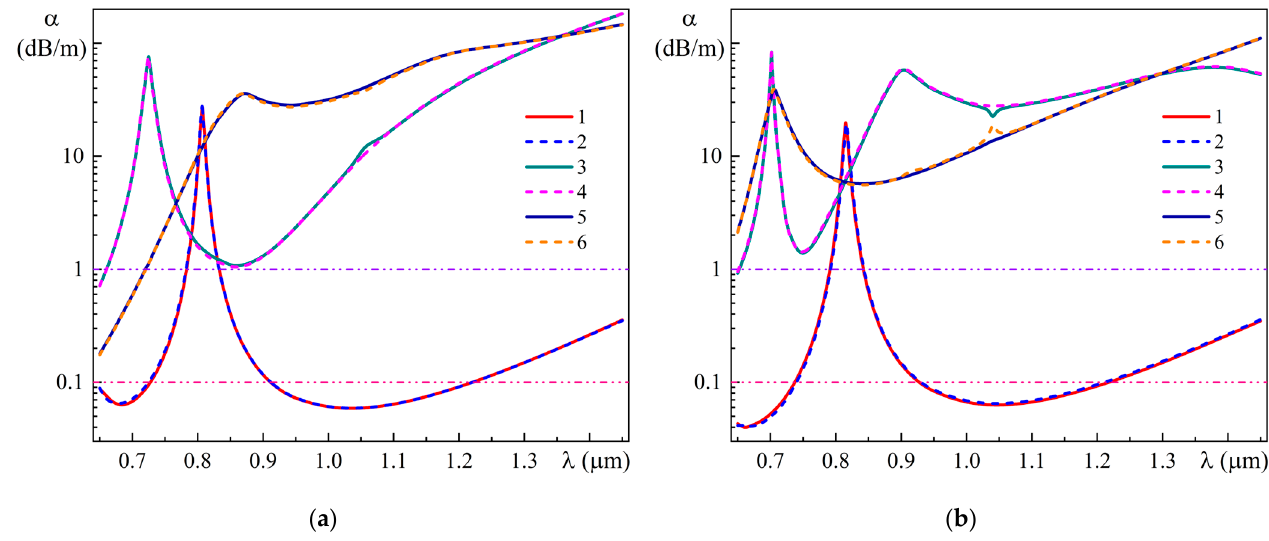
Figure 7. Spectral dependences of leakage losses of (1, 2) fundamental modes and (3–6) higher-order modes in the bent MOF-18 for bending radii: ( a ) R x = 0.08 m and ( b ) R y = 0.08 m.